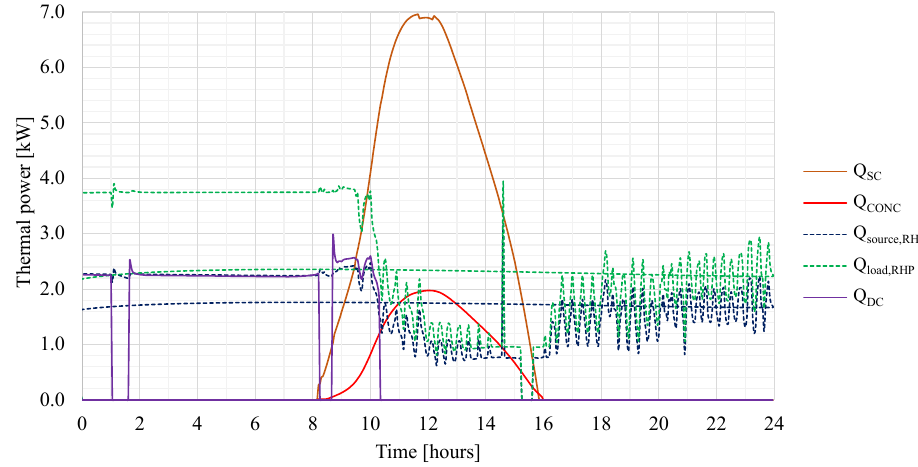
Figure 6. Thermal powers of the main system components, winter day.